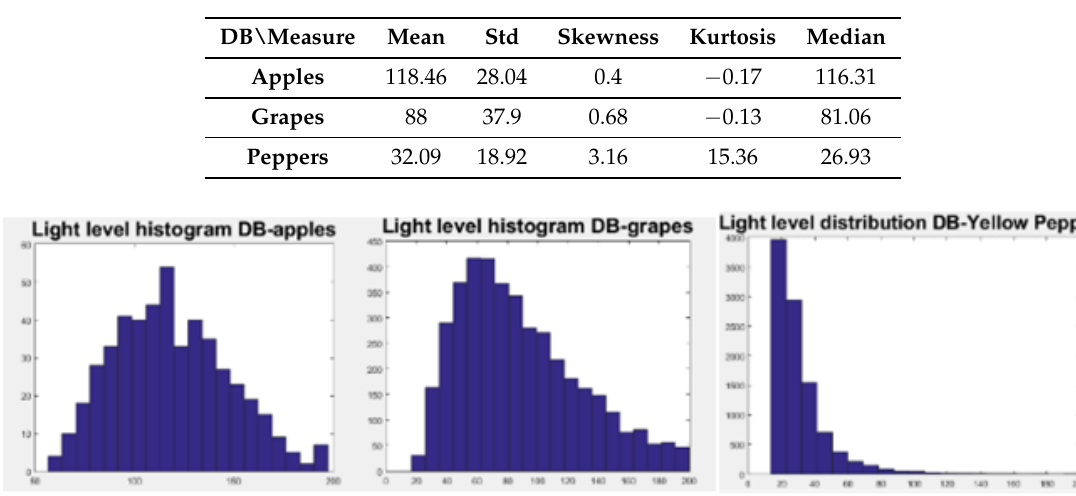
Table 3. Descriptive statistics of the different light distributions.